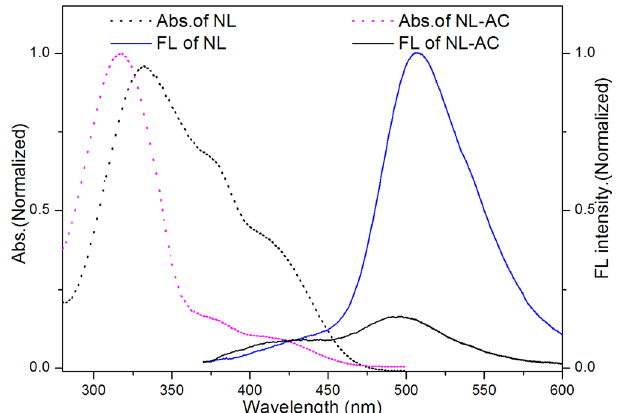
Figure 2. Absorption (dashed lines) and fluorescence (solid lines) spectra of NL-AC (10 µ M) and NL (10 µ M) in DMSO-H